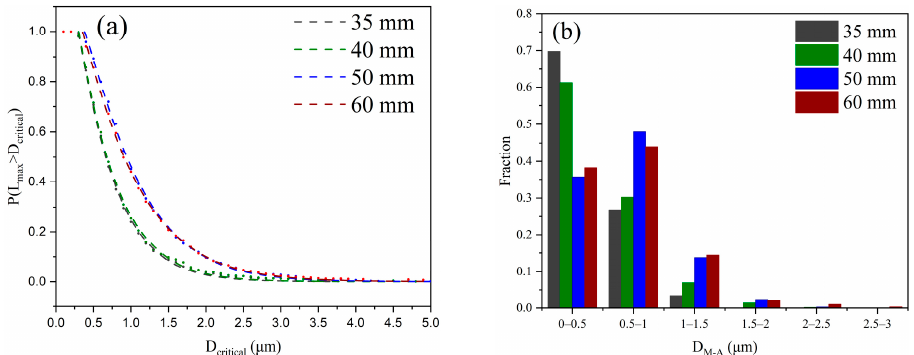
Figure 6. The maximum size of M-A constituents changed with different positions. ( a ) Line fitting using the Weibull function and ( b ) a statistical histogram.